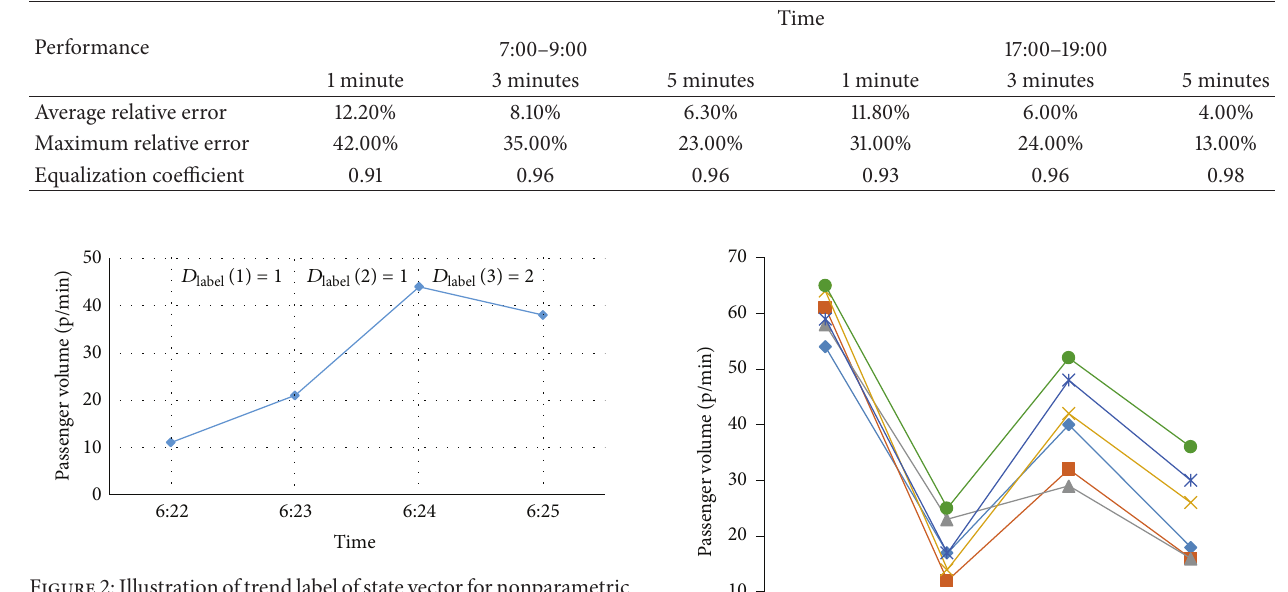
Figure2:Illustrationoftrendlabelofstatevectorfornonparametric regression.